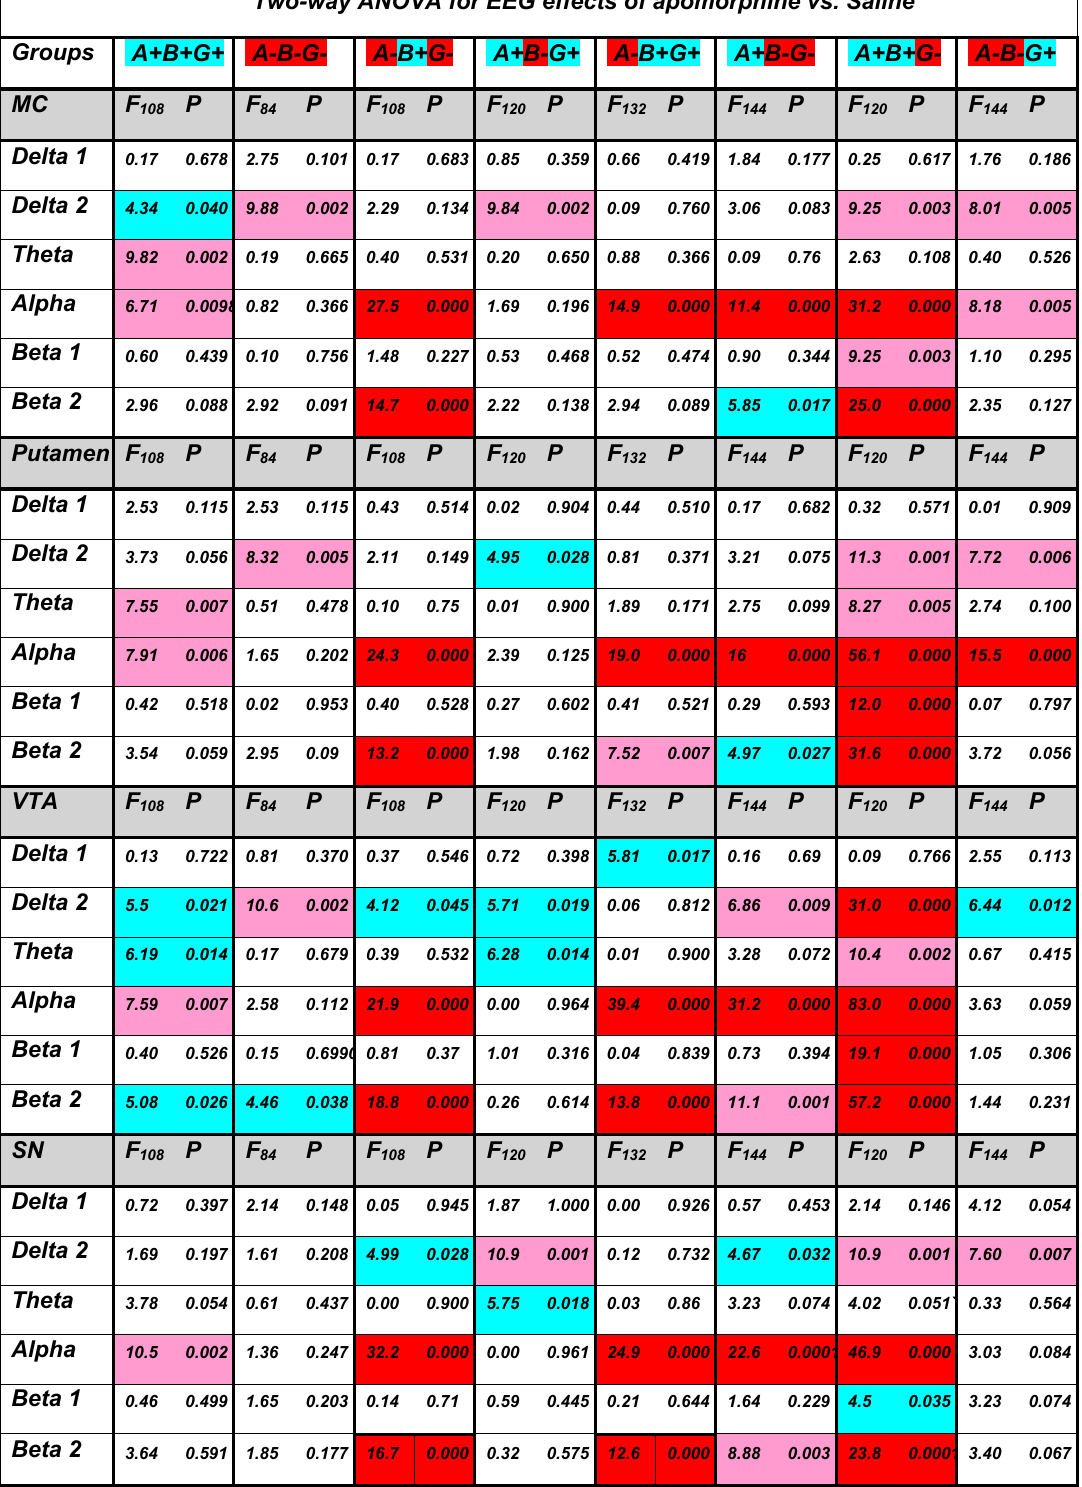
Figure A2. Results of a two-way ANOVA analysis of APO-induced changes in EEG recordings from four brain areas of synuclein KO mice and WT (A+B+G+) mice. Recoding from the same brain areas of mice injected with saline were used as controls. Data with p < 0.05 are highlighted blue, p < 0.01 highlighted pink and p < 0.001 highlighted